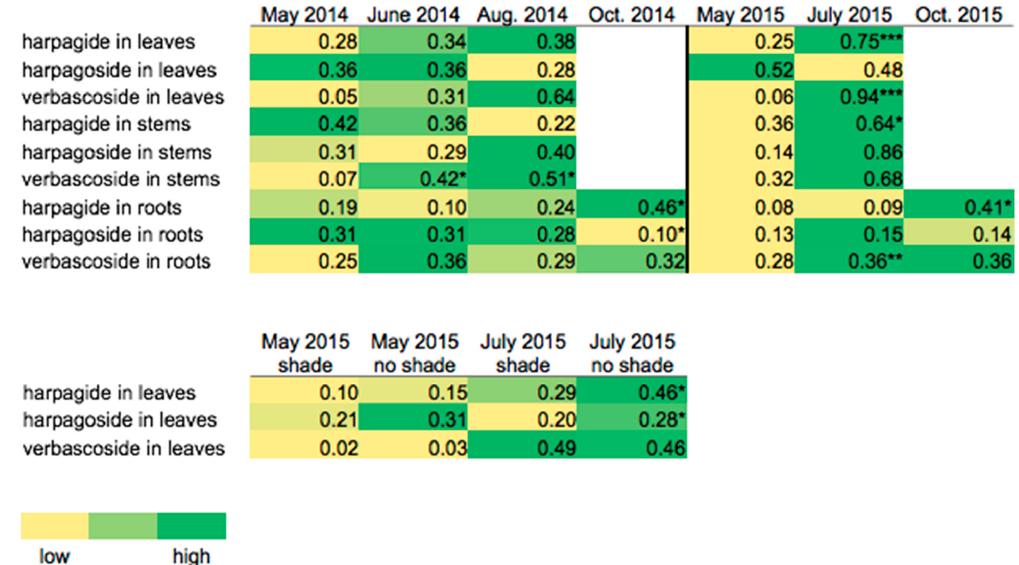
Figure 4. Heatmaps comparing relative abundances (low [0.00] to high [1.00]) of harpagide, harpagoside, and verbascoside in S. lanceolata tissues (leaves, stems, and roots) over the growing season and under shade and no shade treatments. For the October 2014 and October 2015 harvests, the plants had mostly senesced for the season; therefore, only the roots were collected. The vertical black line between the 2014 and 2015 seasons indicates that the seasons are not continuous. Statistical significance ( p ≤ 0.05) was determined by independent/unpaired two-sample t -test or Wilcoxon test. *, significant at p ≤ 0.05; **, significant at p ≤ 0.01; and ***, significant at p ≤ 0.001. Figure S1 shows a bar chart version of this figure.